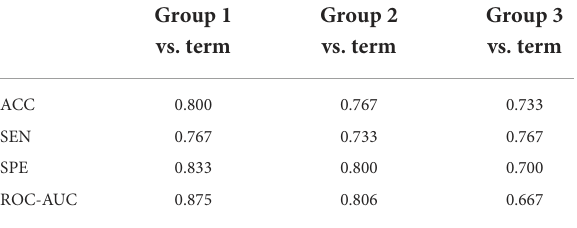
TABLE 5 Classification performance of term and preterm infants in fine-grained